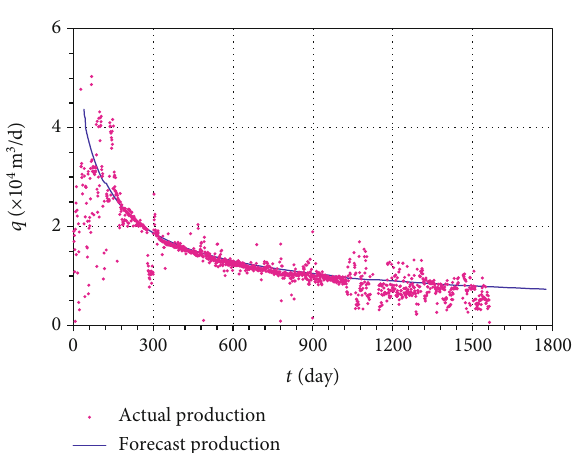
Figure 14: Rate/time curve with varied slope same